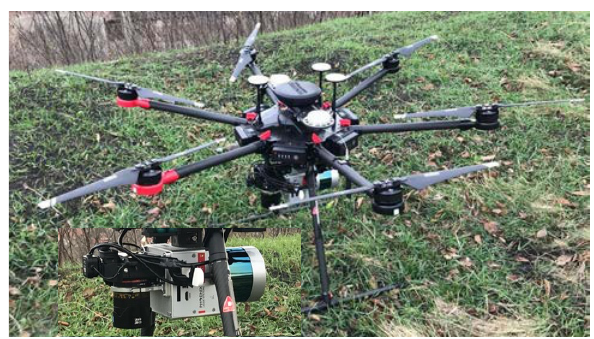
Figure 10. Integrated aerial mapping system